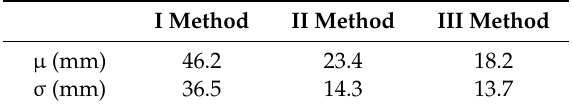
Table 2. Mean error of the optical and acoustic registration of the target with objects.